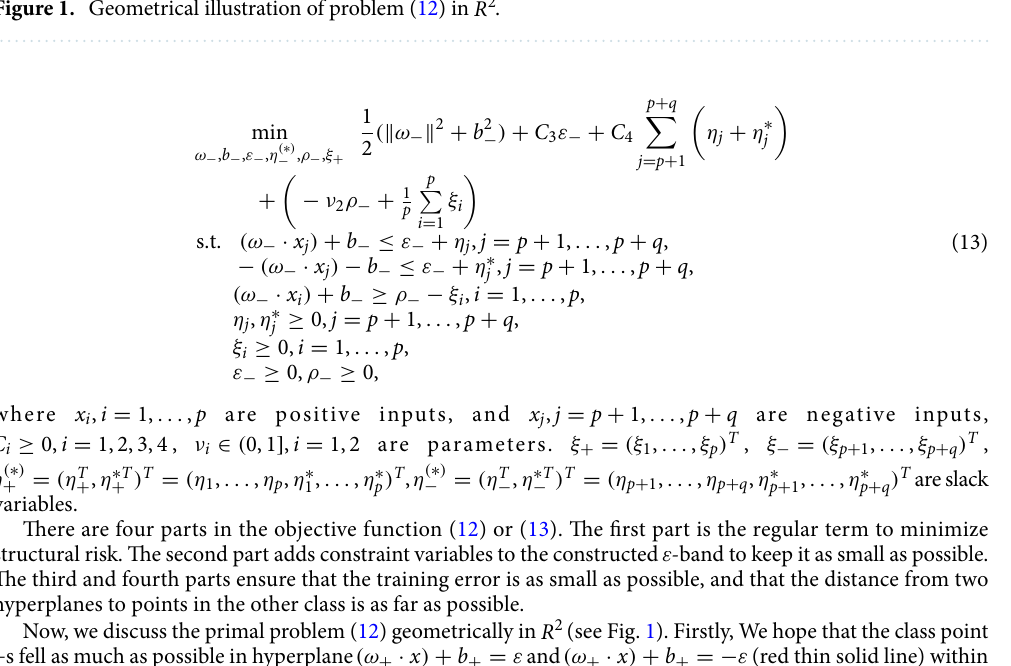
Figure 1. Geometrical illustration of problem (12) in R 2